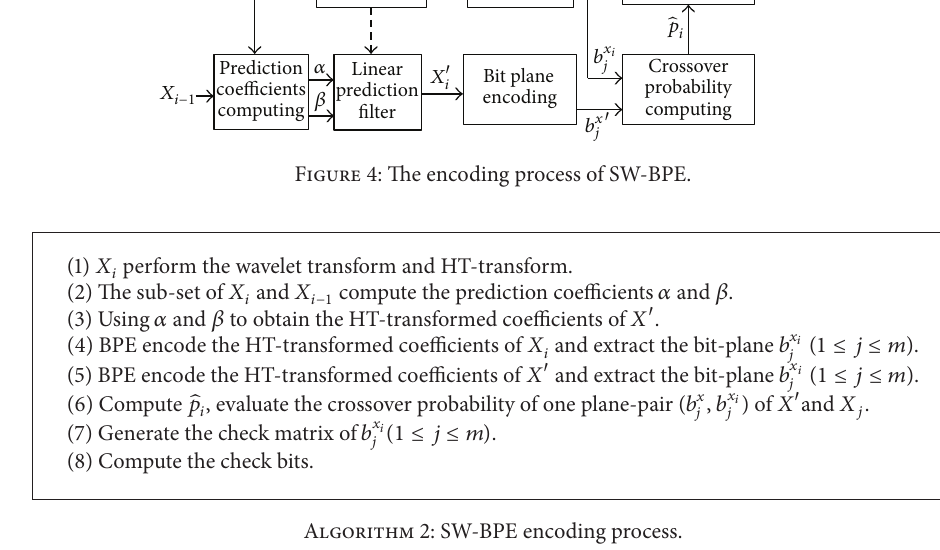
Algorithm 2: SW-BPE encoding process.